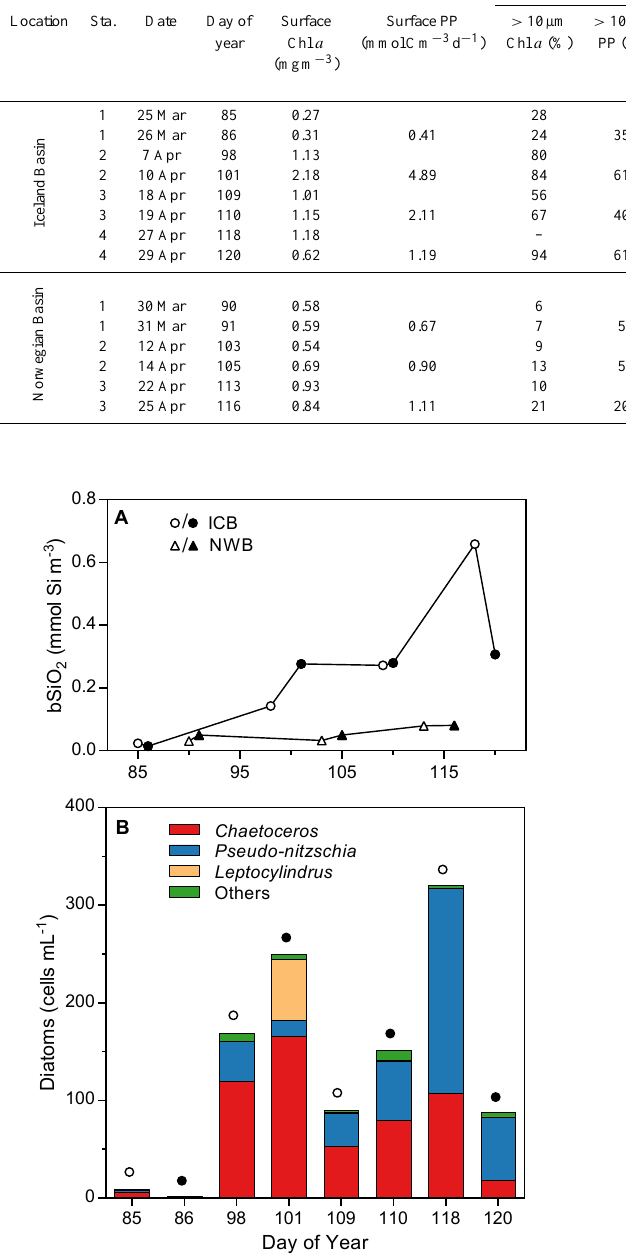
Figure 4. Surface (5–15m) measurements of (a) particulate sili- cate (bSiO 2 ) and (b) diatom species abundance in the Iceland Basin. Black symbols indicate where diatoms were counted from Lugol’s samples, while open symbols indicate SEM counts.